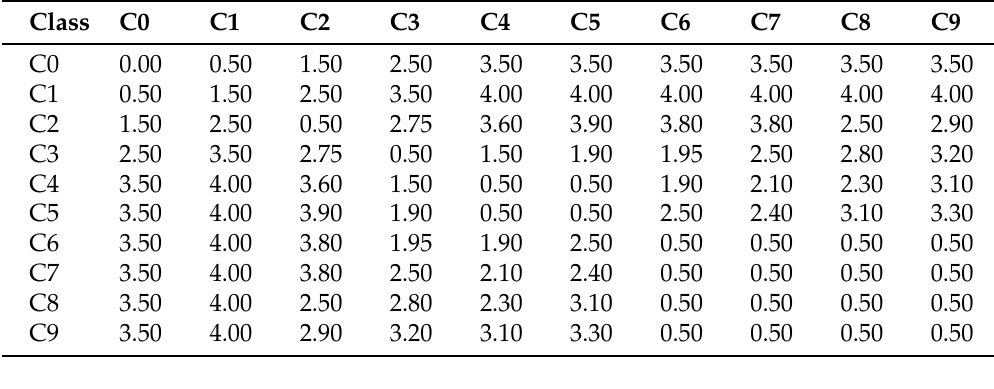
Table 10. Comparison of within-class (average distance) and between-class (average linkage) dis- tances for SFDDD dataset.